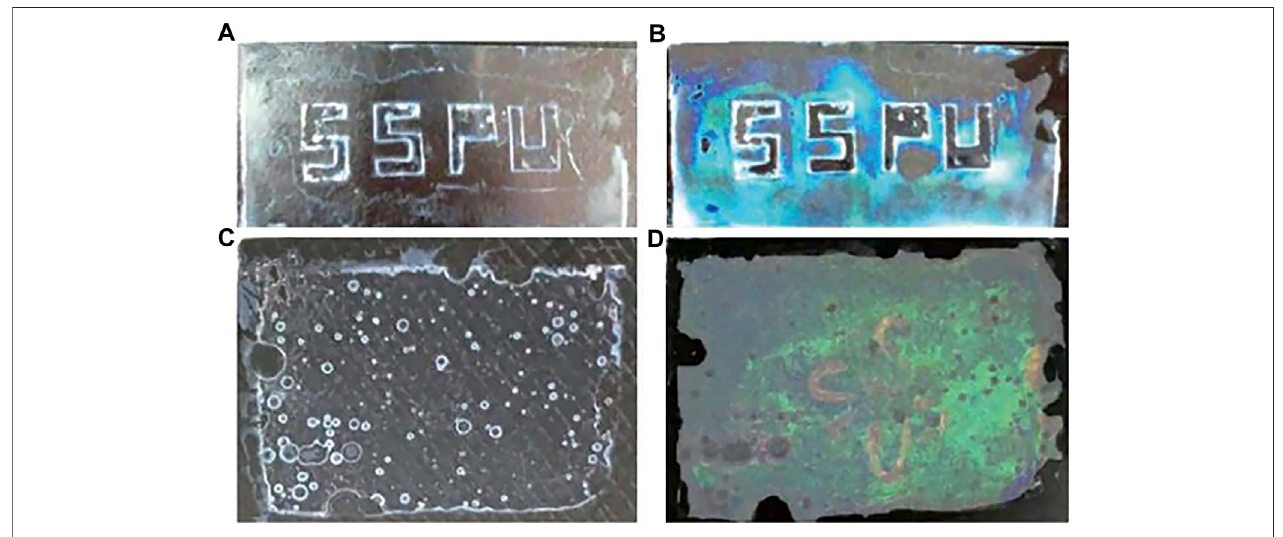
FIGURE 12 | 2D-PC material with invisible markings: (A) colorless and transparent when dehydrated; (B) PC fi lm with blue and green when rehydrated; (C) colorless and transparent when dehydrated; (D) The PC fi lm turned green while the printed part showed red (Chen et al., 2017b).